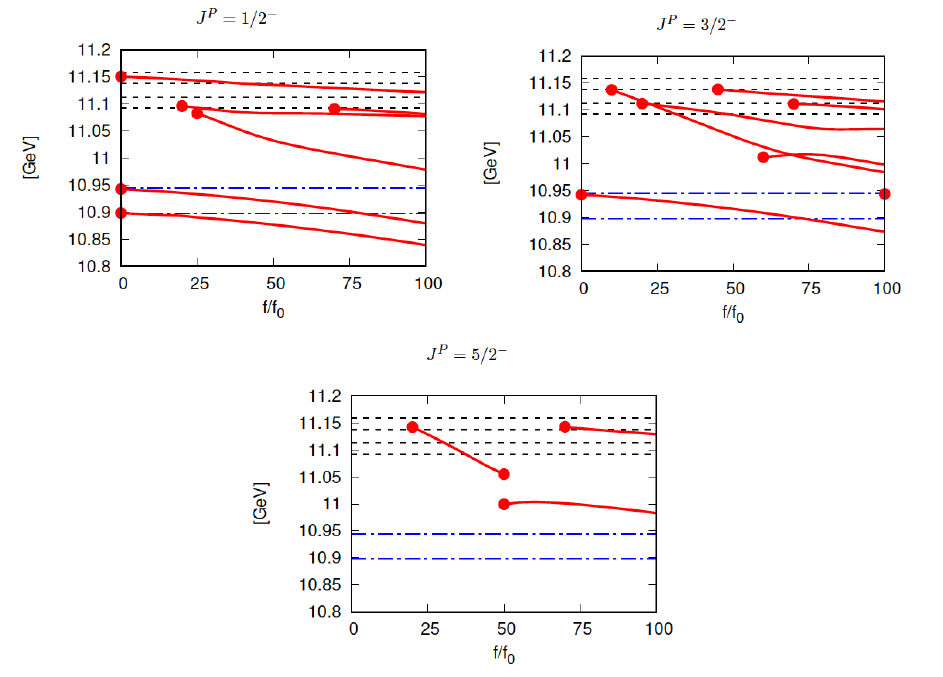
Figure 6. Bound and resonant state energies of the hidden-bottom molecules (solid lines) with var- ious coupling constants f. Dot-dashed lines are the ¯ B Λ b and ¯ B ∗ Λ b thresholds. Dashed lines are the ¯ B Σ ¯ B Σ ∗ , ¯ B ∗ Σ b and ¯ B ∗ Σ ∗ thresholds. The lowest threshold, ¯ B Λ b , is at about 10900 MeV and the b , b b